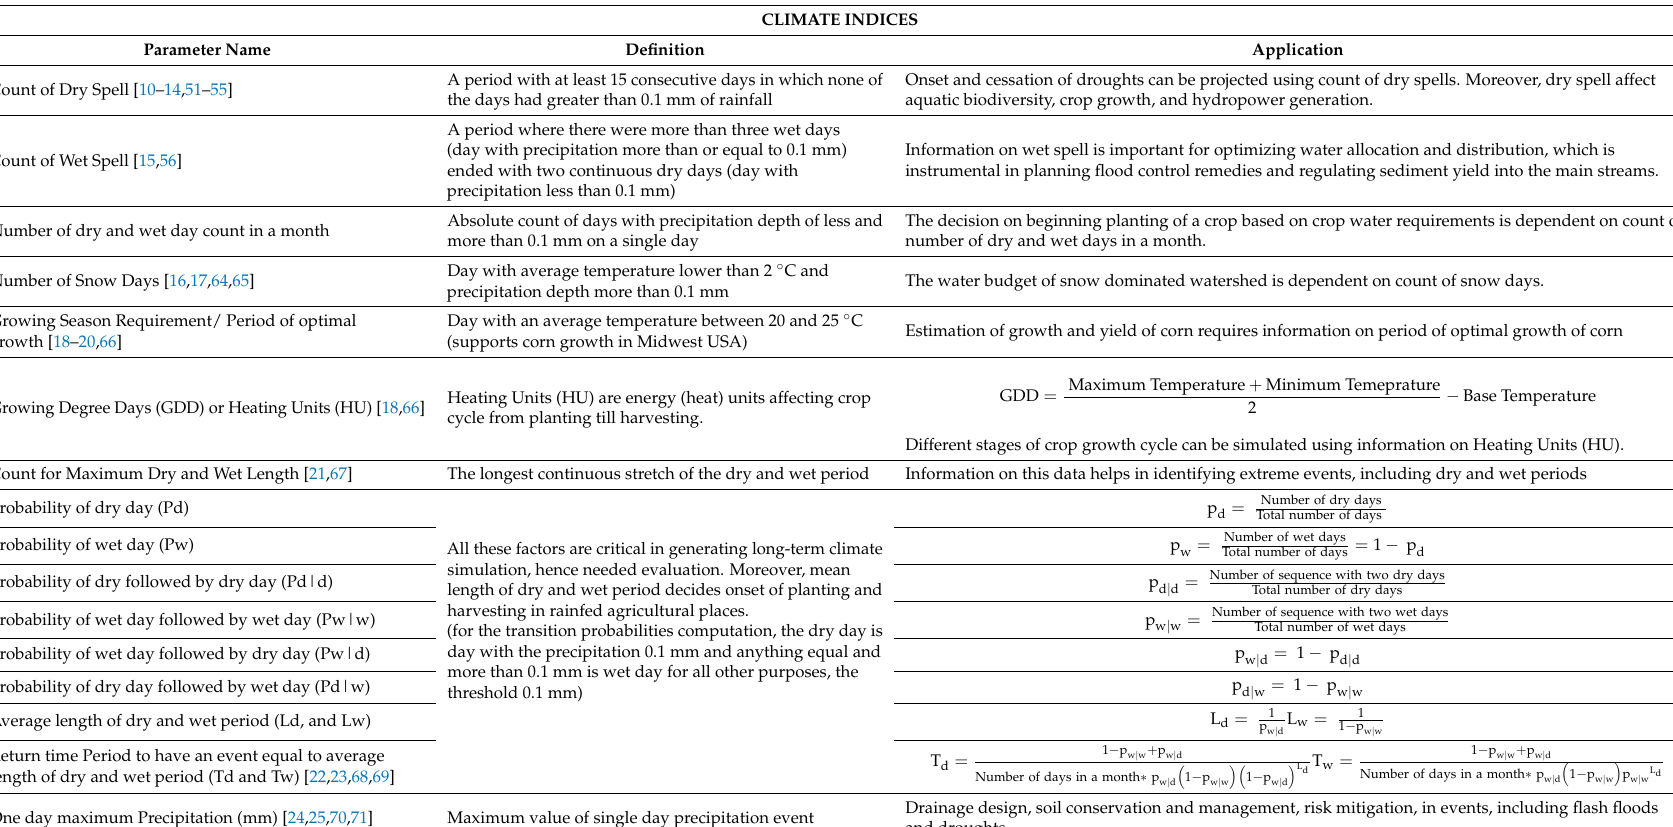
Table 2. List with explanation, application, and computational formula for various climate indices, verification skill scores, and performance